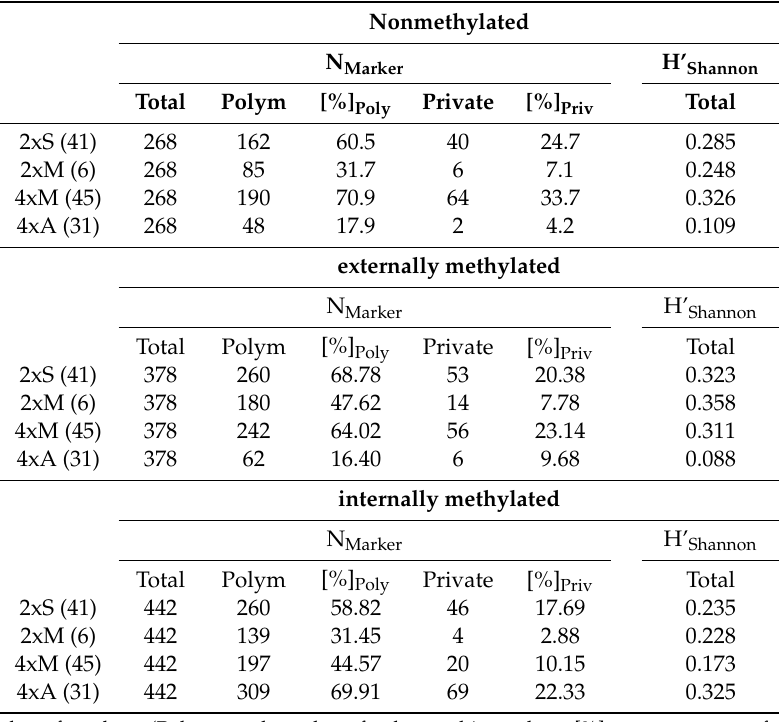
Table 2. Descriptive statistical parameters of variation of epiloci of combined